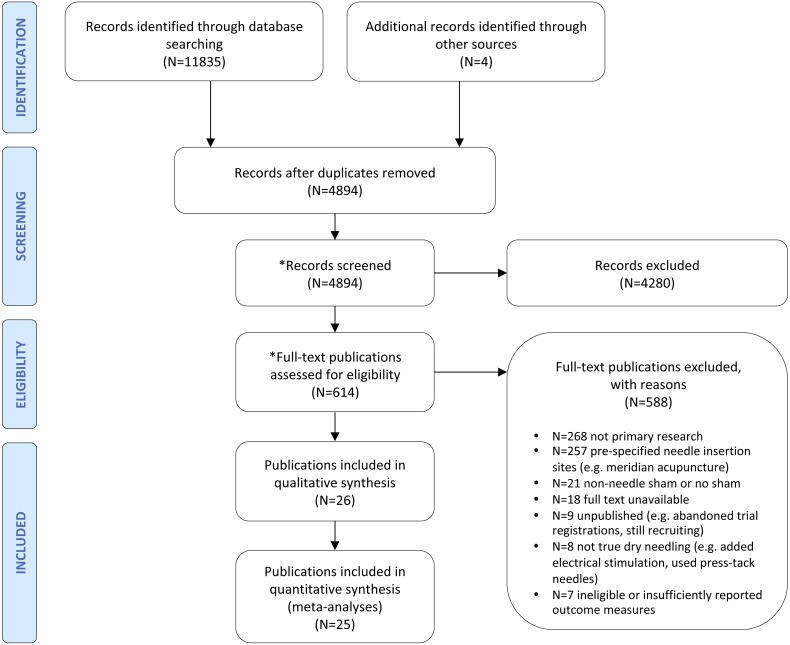
Preferred Reporting Items for Systematic Reviews and Meta-Analyses (PRISMA) flow diagram (http://www.prisma-statement.org).*Processes performed by two independent reviewers.